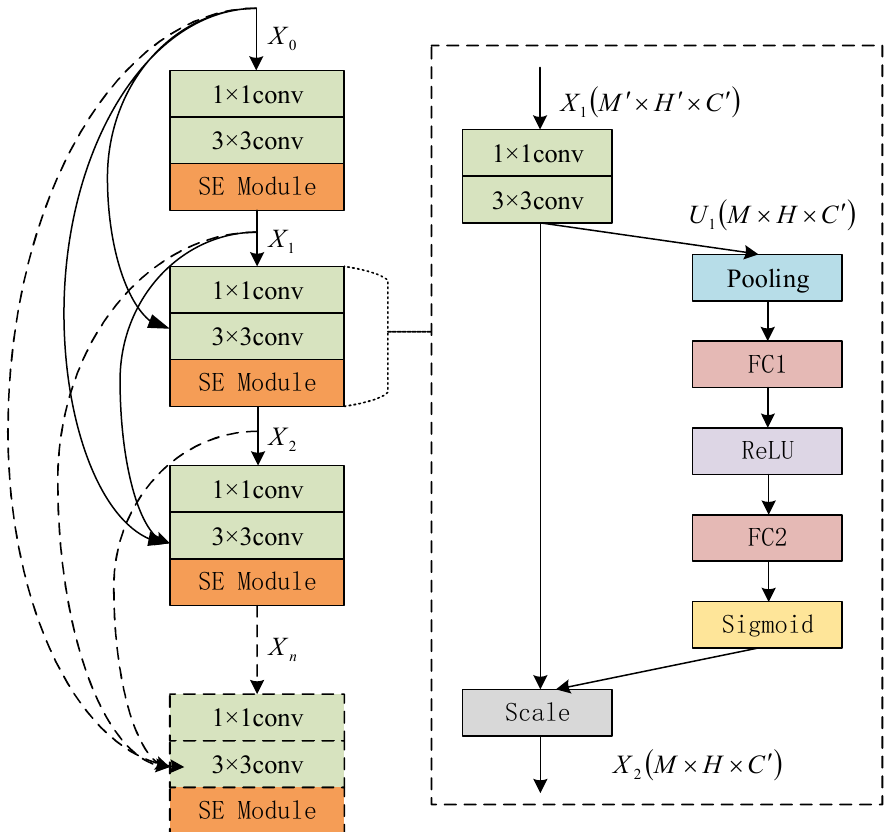
Figure 5. SE-DenseNet model diagram.